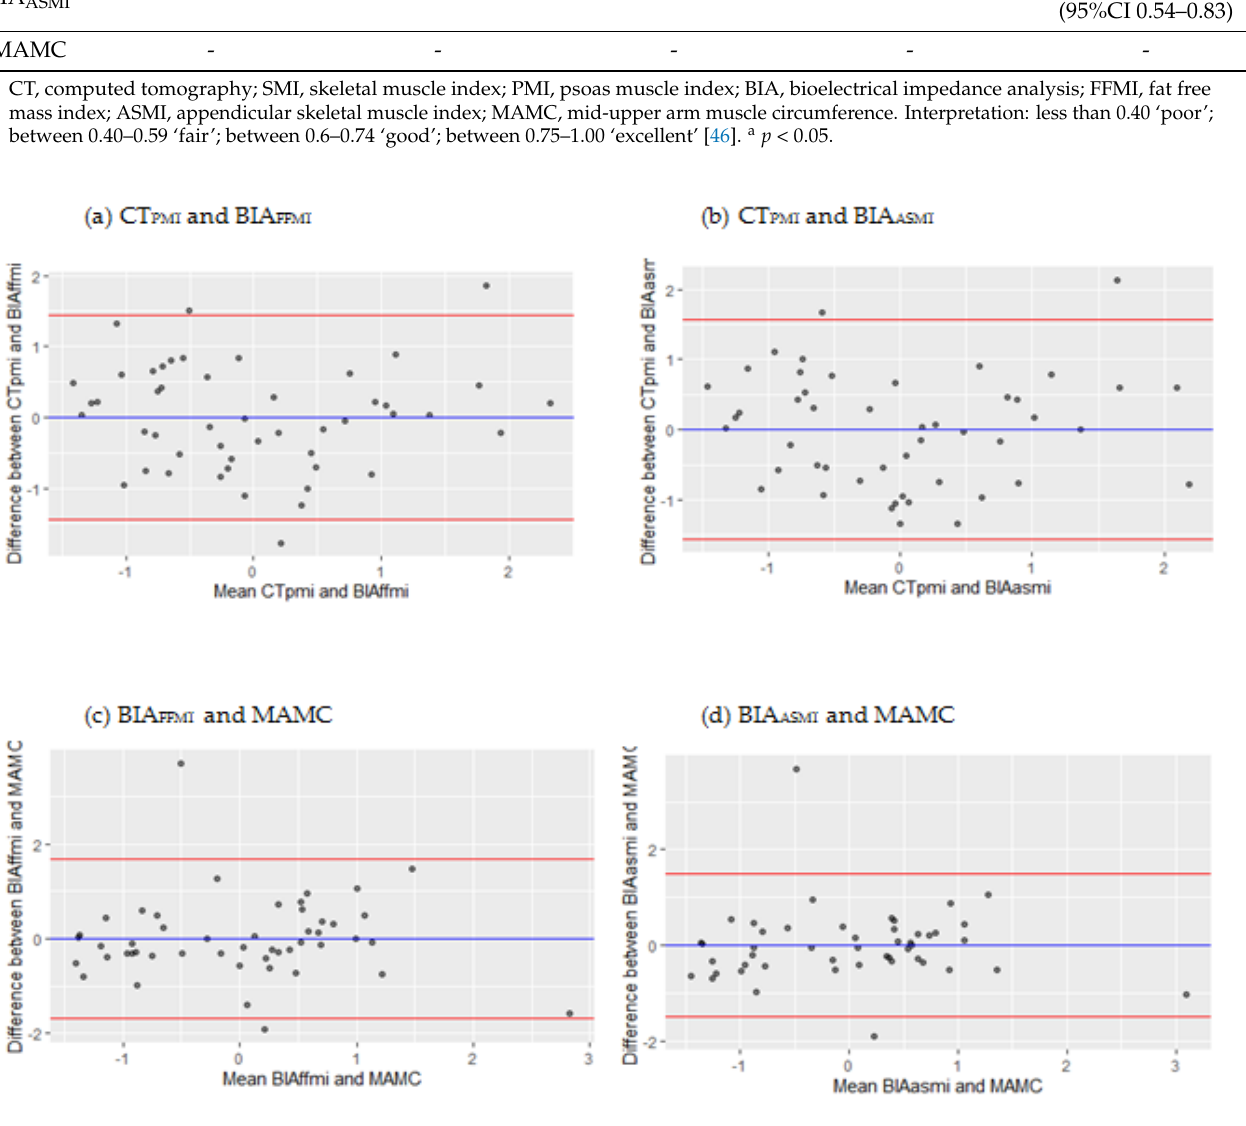
Figure 2. Bland − Altman plots showing absolute differences based on z-scores between muscle mass methods against the mean of the two measurements in the total sample.